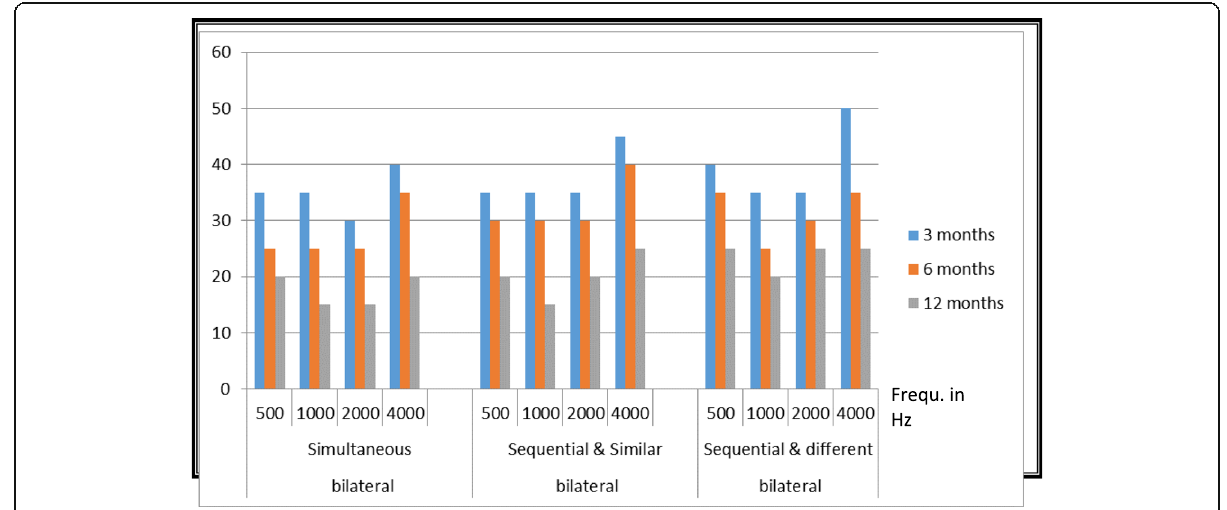
Fig. 2 Comparison of aided threshold performance change of bilateral implant at 3, 6, and 12 months of the second implant